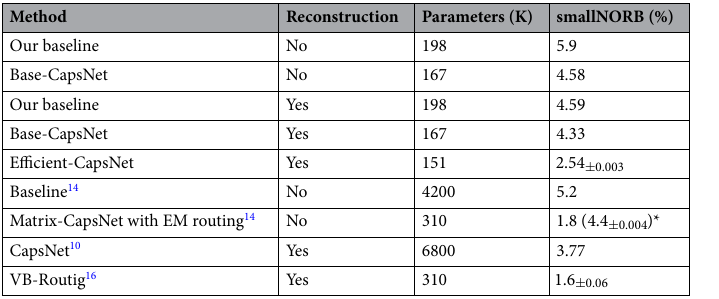
Table 4. Test error (%) on the smallNORB classification task. All methodologies are reported with their number of parameters andthe presence of the reconstruction regularizer during the training phase. * indicates the results from our